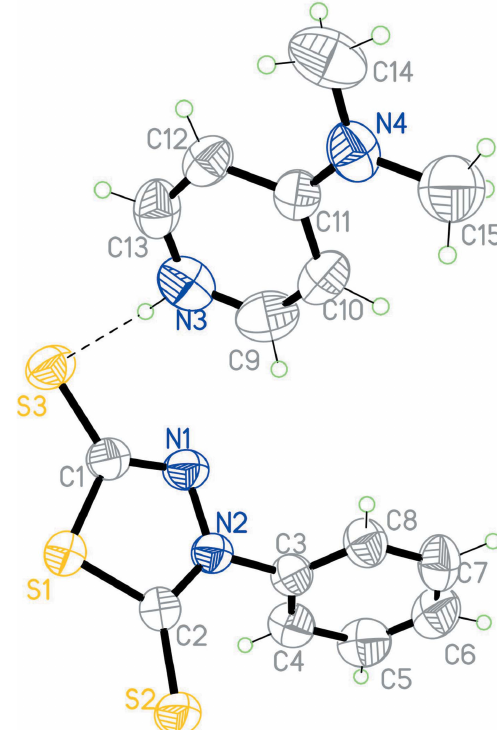
Figure 2 The molecular structure of compound (II), with the atom labeling and displacement ellipsoids drawn at the 40% probability level. The dashed line represents the intramolecular hydrogen bond.